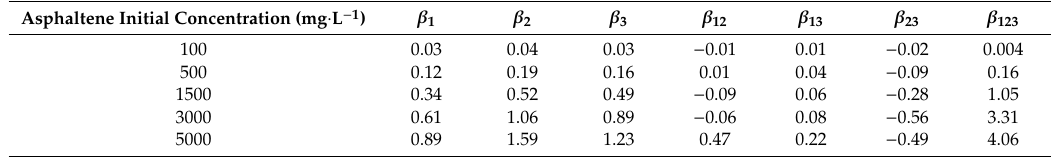
Figure 11. Asphaltene adsorption isotherms for nanoparticles SiO 2 , SiNi1Mo1, and SiNi0.66Mo0.66 at 25 °C. The symbols are experimental data, and the solid lines are from the SLE model. Adsorption isotherm predictions for the Si-Ni-Mo system are presented in Table 6. Figure 12a shows the adsorption isotherm of SiNi0.5Mo0.5 nanoparticles, which, when compared with the theoretical data, demonstrates an error of 9.58% based on the special cubic model. Table 6. Coefficients of the Special Cubic Model for mixture design using Si-Ni-Mo nanomaterial for asphaltene adsorption.